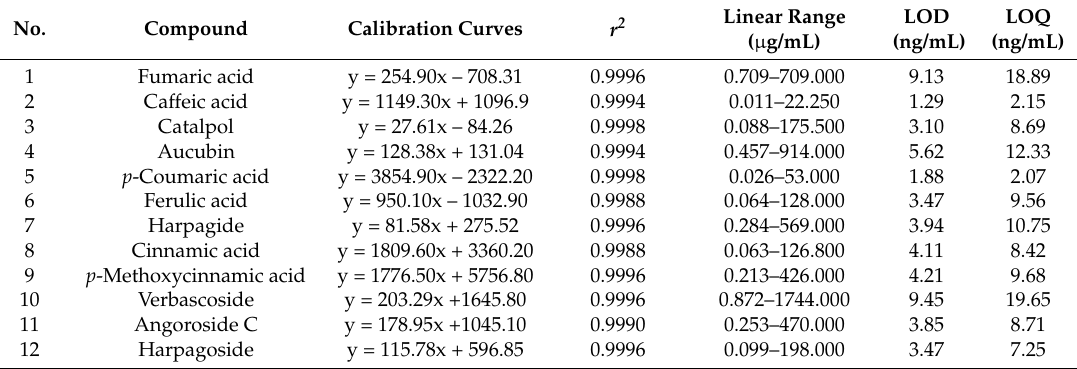
Table 2. Regression equation, correlation coefficients, linearity ranges, and limits of detection (LOD) and quantitation (LOQ) of the 12 investigated